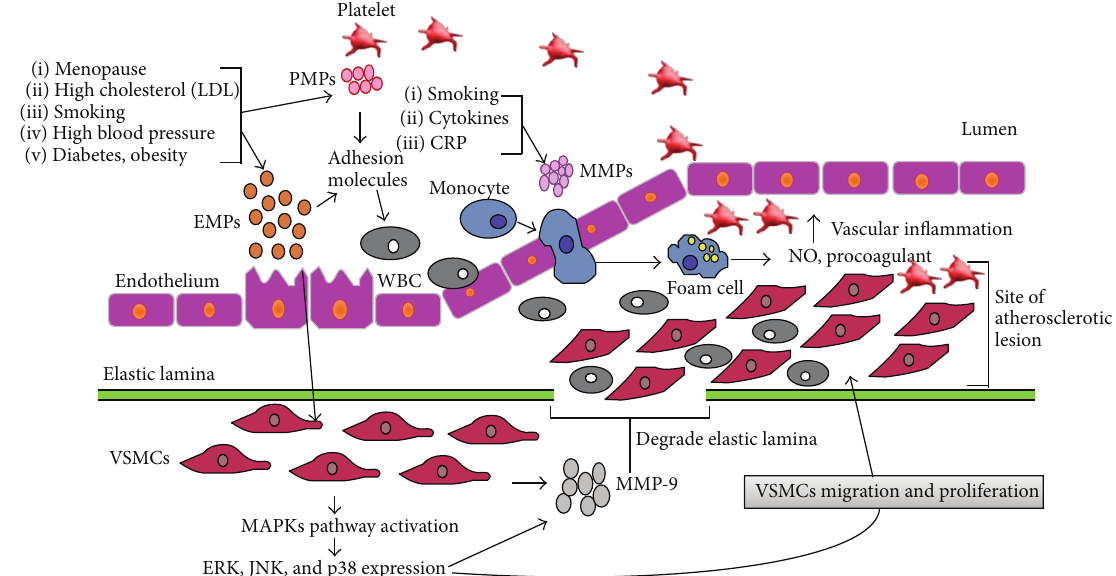
Figure 1: The chain of events initiated by MPs on atherosclerosis physiopathology. Endothelial microparticles (EMPs) and platelet microparticles (PMPs) are generated by the activation of endothelium with a number of factors like smoking, oxidative stress, obesity, and high blood pressure whereas monocyte-microparticles (MMPs) are generated by proinflammatory cytokines (tumor necrosis factor- 𝛼 , interleukin 1- 𝛽 ), cigarette smoking, and C-reactive protein (CRP). EMPs can activate vascular smooth muscle cells (VSMCs) to express matrix metalloproteinase-9 (MMP-9) that can degrade elastic lamina barrier to facilitate VSMC migration from tunic media to tunic intima at the site of atherosclerotic lesion. Furthermore, EMPs also upregulate ERK, JNK, and p38 through MAPKs pathway leading to proliferation and migration of VSMC to develop atheroma plaque. Cell adhesion molecules expressed by EMPs and PMPs facilitate leukocytes and platelets adhesion to the endothelial surface thereby developing intimal thickening and vascular lesion. MMPs can activate inducible nitric oxide synthase pathway to release nitric oxide (NO) and procoagulant responsible for vascular inflammation and endothelial dysfunction. Collectively, all this event leads to